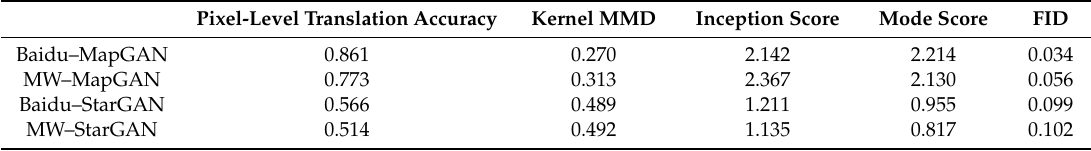
Table 3. Evaluation results of the Baidu and Map World (MW) electronic maps generated by MapGAN and StarGAN in the one-to-many map generation experiment under five di ff erent indicators. From top to bottom are the evaluation results of the Baidu maps generated by MapGAN, the Map World maps generated by MapGAN, the Baidu maps generated by StarGAN, and the Map World maps generated by StarGAN.